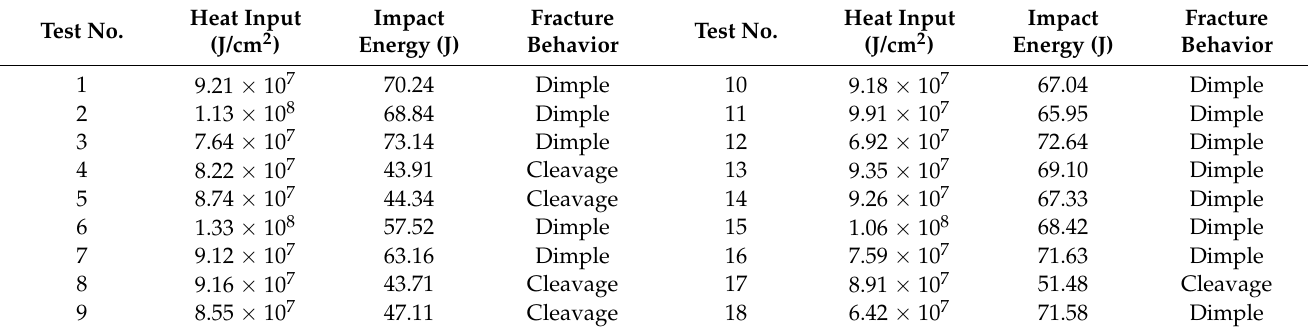
Table 9. Brittle fracture behavior data for discriminant analysis in fiber laser